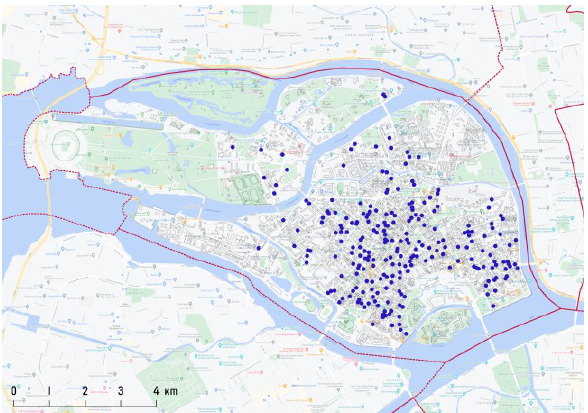
Figure 1. Tuberculosis infection cases observed in the